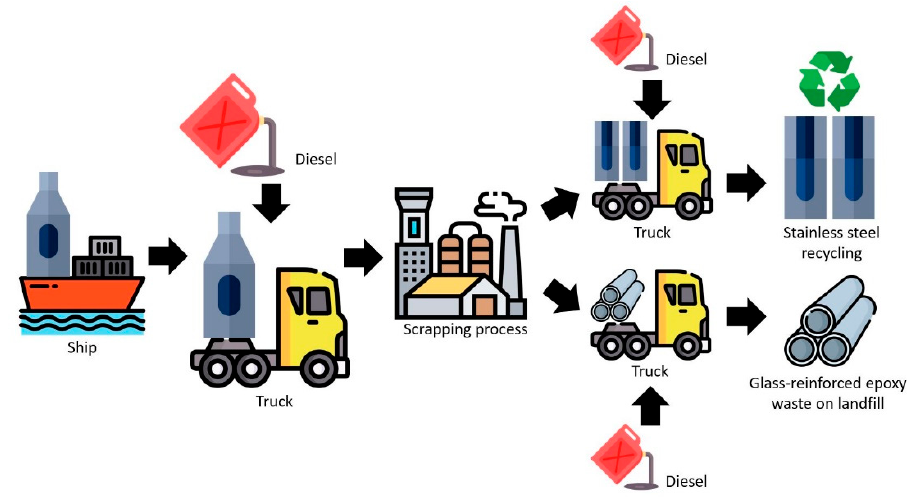
Figure 5. LCA model for operation phase of scrubber system.